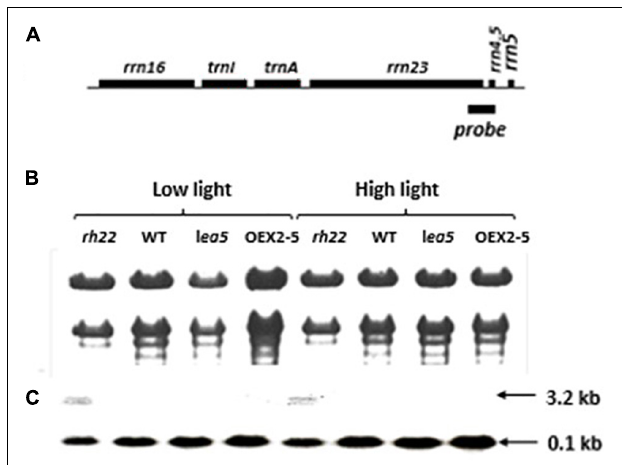
FIGURE 4 | Expression and processing of chloroplast rRNA in Wild type (WT) Arabidopsis, a knockout line defective in DEA (D/H)-box RNA helicase 22 ( (cid:49) rh22), a knockout line defective in LEA5 ( lea5 ) and a transformed Arabidopsis line overexpressing LEA5 (OEX2-5). (A) A diagram of the chloroplast rRNA operon showing the location of the probe used for the RNA gel-blot analysis. (B) Ethidium bromide staining of glyoxylated RNA separated on 1.2% agarose extracted from plants grown under either low or high light conditions. (C) Northern blot